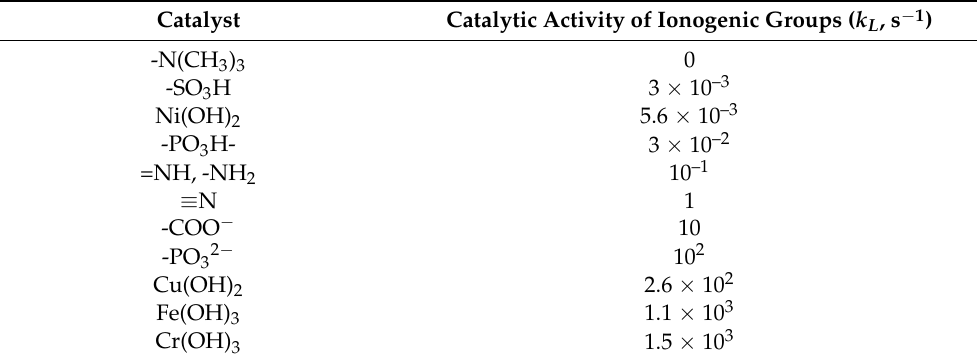
Table 1. Catalytic activity of ionogenic groups